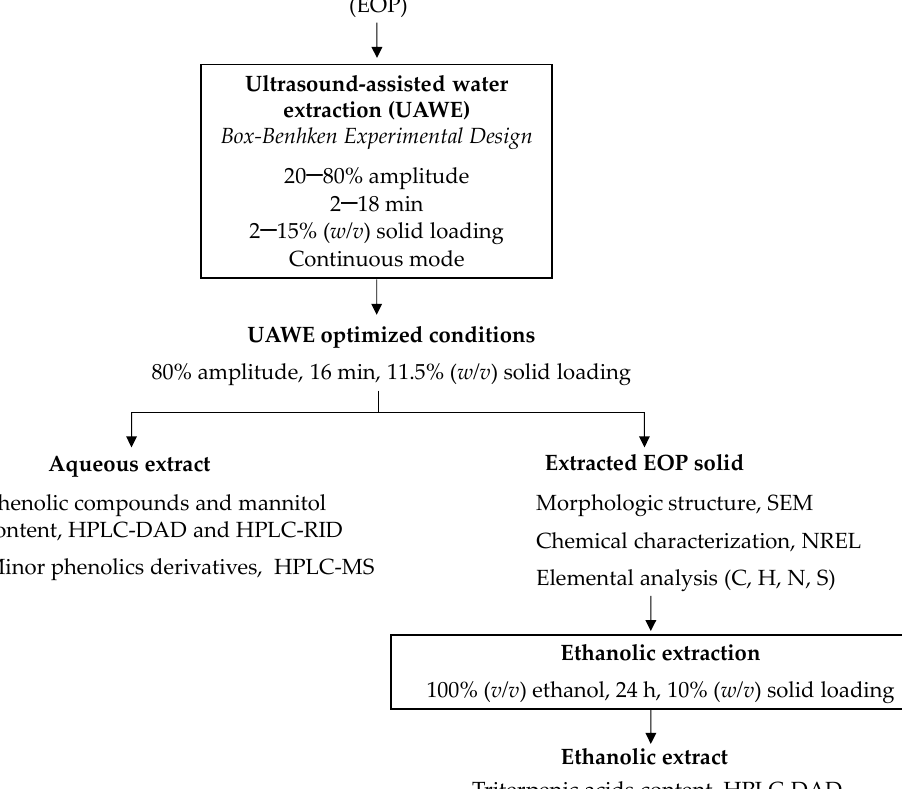
Figure 1. Scheme of the experimental procedure and the characterization techniques. Firstly, the effect of milling was tested, while using a Box–Behnken design (BBD), UAWE operational parameters (extraction time, solid loading, and amplitude) were eval- uated to obtain phenolic compounds and mannitol. Moreover, the extracts obtained under optimized conditions were further characterized by high-performance liquid chro- matography (HPLC)-ion trap mass spectrometry (IT-MS) to profile minor hydroxytyrosol derivatives. The structural changes of the extracted solid obtained under UAWE optimized conditions were studied by scanning electron microscopy (SEM) and it was also chemically characterized. Then, that solid was subjected to a second extraction step using ethanol to obtain maslinic acid and oleanolic acid and the effect of the previous step was